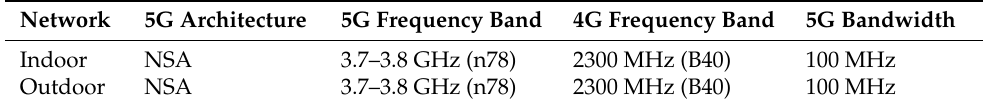
Table 2. Indoor and outdoor 5G network